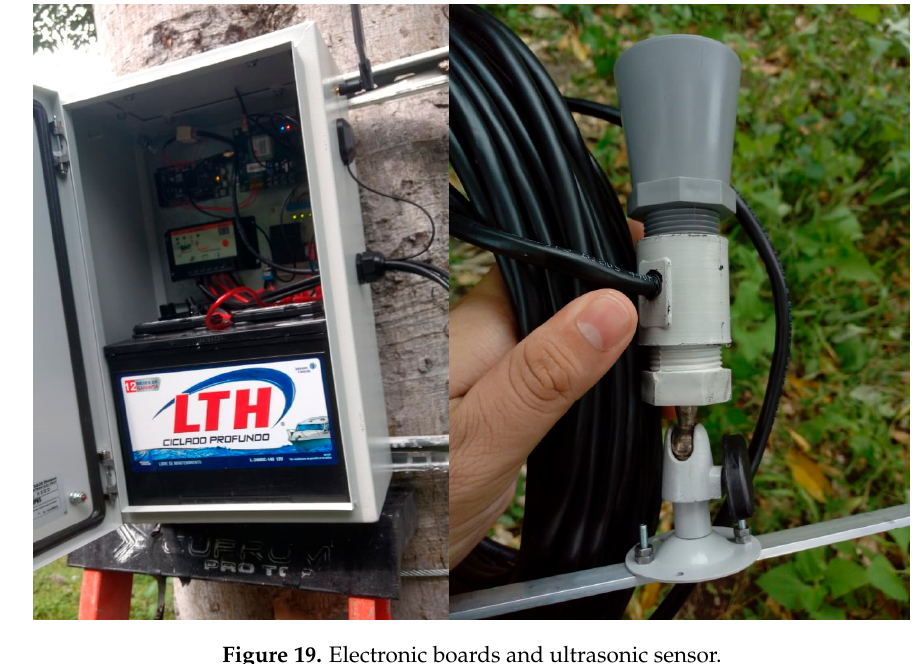
Figure 19. Electronic boards and ultrasonic sensor.